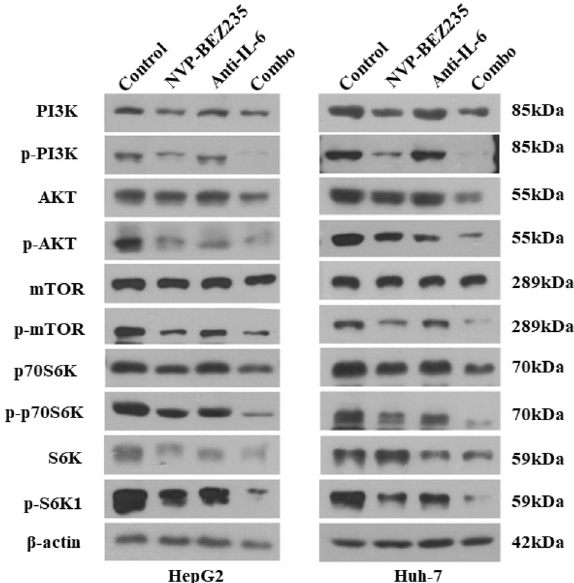
Fig. 6 Inhibition of IL-6 combined with NVP-BEZ235 synergisti- cally suppresses the PI3K/AKT/mTOR pathway in HCC cells. Combined treatment inhibited activation of the PI3K/AKT/mTOR pathway in HepG2 and Huh-7 cells. The expression pattern of PI3K/ AKT/mTOR pathway-associated proteins was analyzed using wes- tern